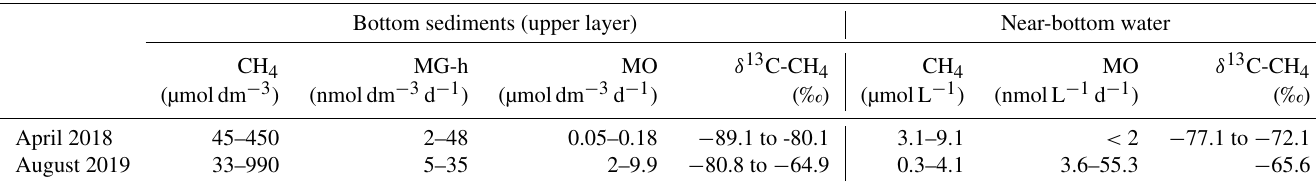
Table 4. Methane concentrations and rates of microbial processes of the methane cycle in the near-bottom water layer and bottom sediments of Yamal lakes in April 2018 (Savvichev et al., 2018a) and August 2019. Bottom sediments (upper layer)